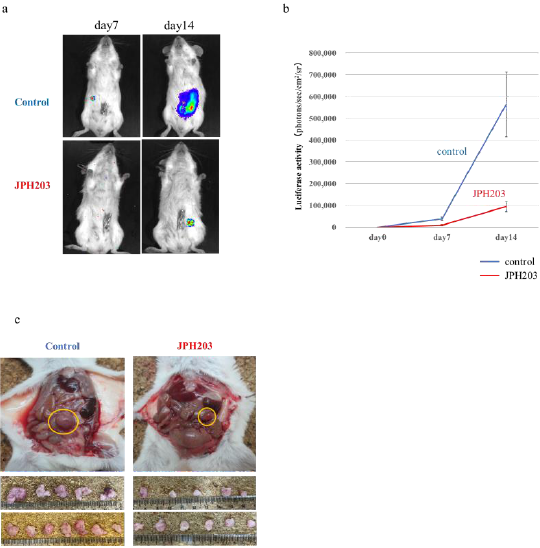
Figure 3. Effect of JPH203 on orthotopic implanted tumor (Control group; n = 12 vs. JPH203 treatment group; n = 11). ( a ) Representative image of tumor obtained by luminescence observation (Days 7 and 14 post-transplantation). ( b ) Quantification of changes over time according to luminous intensity. Student’s t -test was conducted for statistical analysis. ( c ) Macroscopic images of mouse tumors after sacrifice on day 14 post-transplantation.